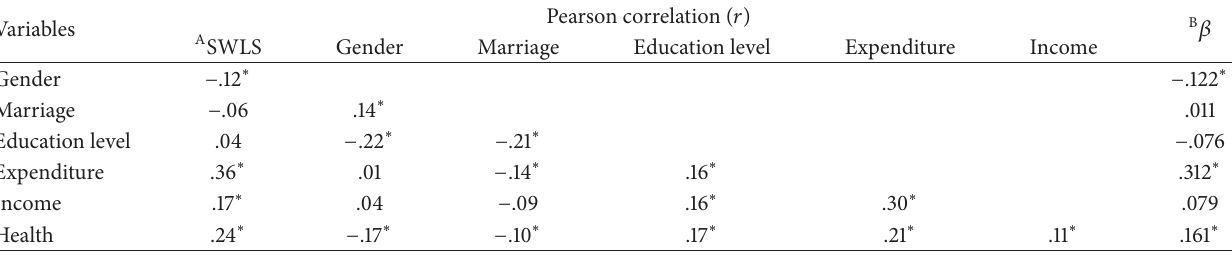
Table3:CorrelationsandresultsfromregressionanalysesofdemographicvariablesinassociationwithSWLSscoreinyoung-oldparticipants. Variables